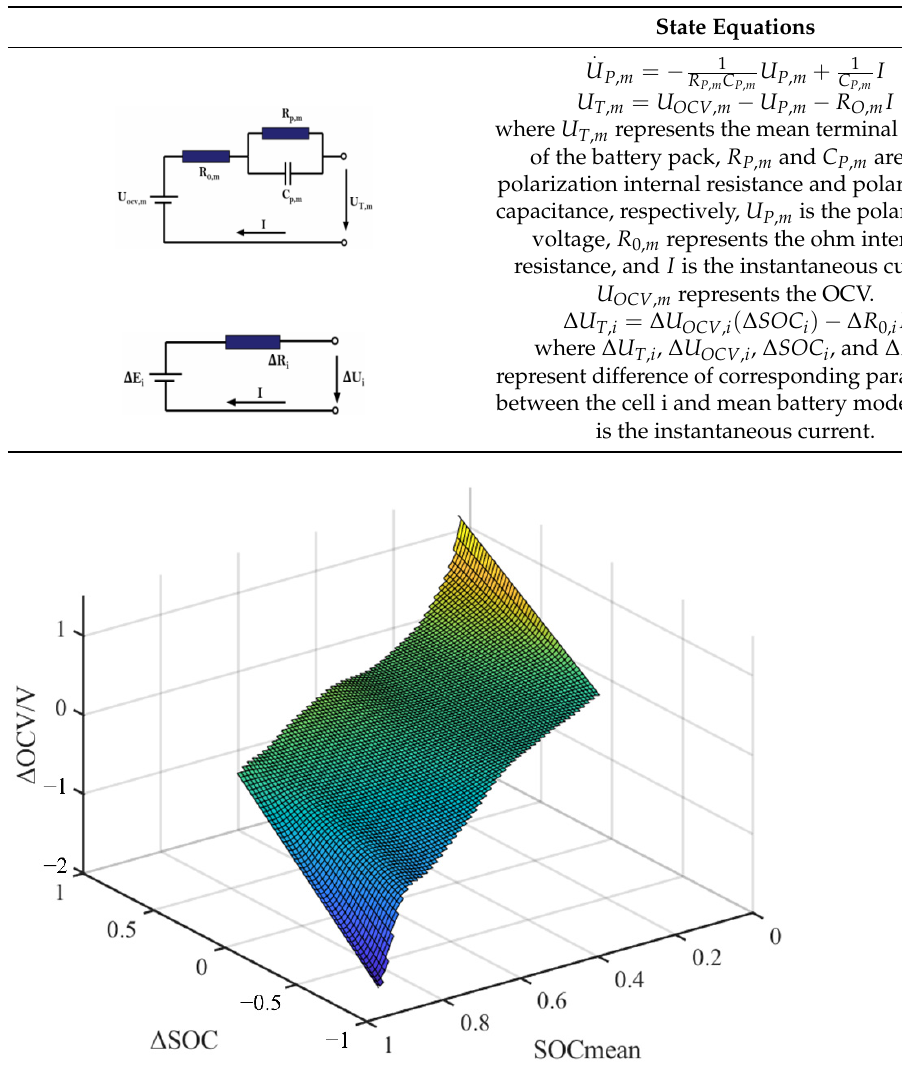
Table 1. State equations of MDM#2 model [12].